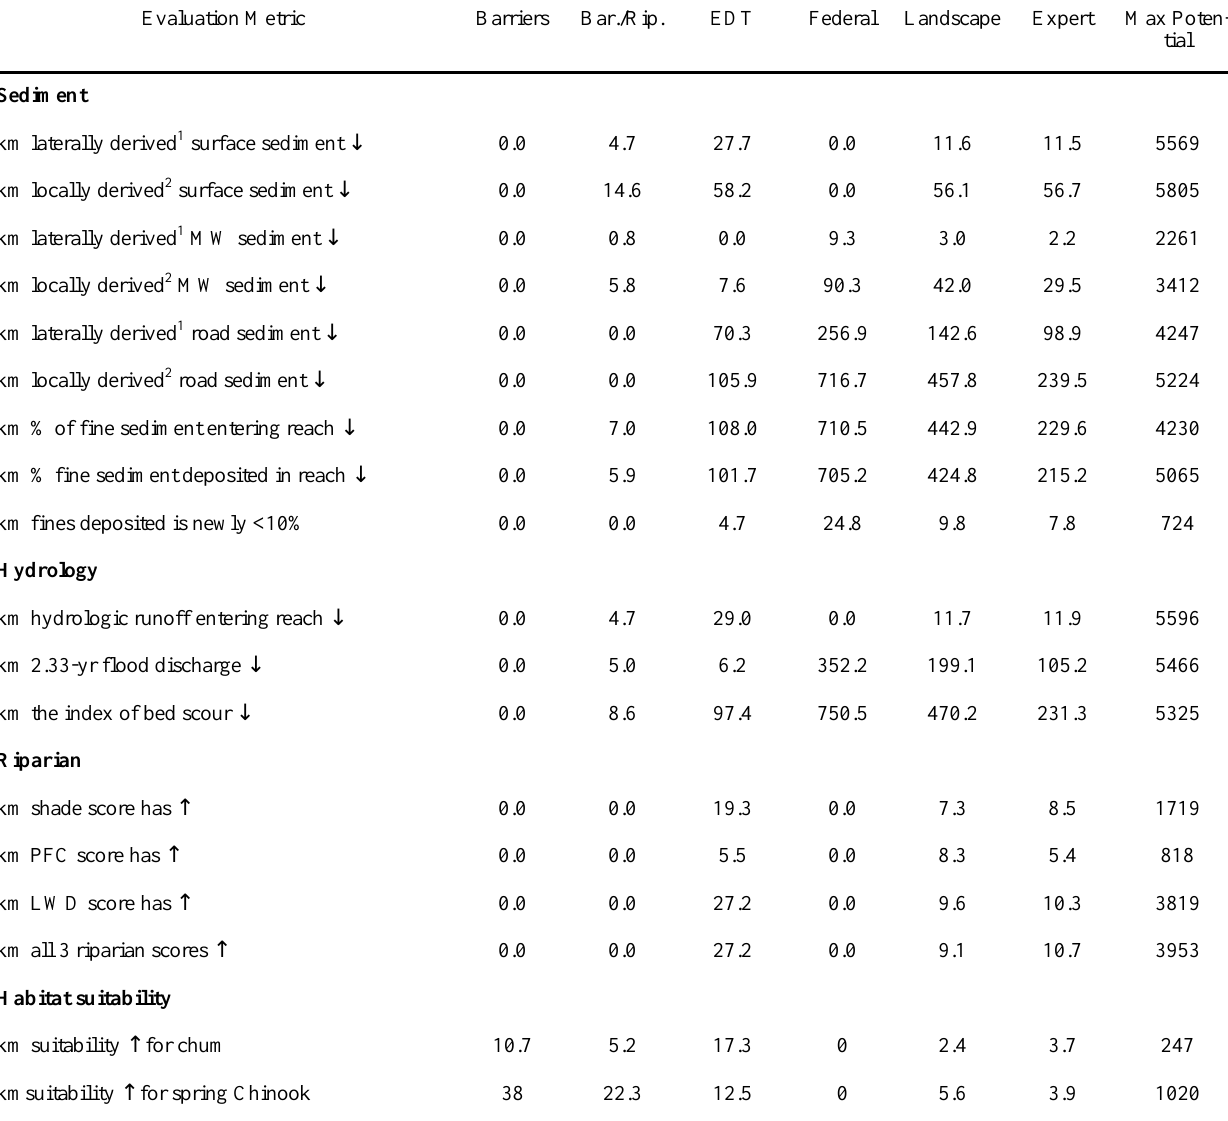
Table 5. Results for selected metrics used to evaluate future impacts of each of the six watershed management strategies. Evaluation metrics are summarized over all reaches in the watershed for sediment, hydrology, and riparian metrics, and over reaches currently accessible to winter steelhead for habitat suitability, spawner capacity, and egg-to-fry survival. Newly accessible habitat is summarized for each species. The maximum potential column describes the difference between estimates for current and historical conditions, an estimate of the maximum improvement in habitat condition or biological response that could be expected with infinite resources. Habitat suitability improvements include increases in both quantity and quality of habitat. Barriers and Riparian management strategy (Bar./Rip.), mass wasting (MW), pool-forming conifers (PFC), large woody debris (LWD), 90% confidence interval (CI); change ( D ), an increase in the value over current conditions ( › ), a decrease in the value ( fl ). Fine sediment = 0.25 to 1.0 mm. 1 Laterally derived sediment is sediment entering a reach from adjacent hillslopes.